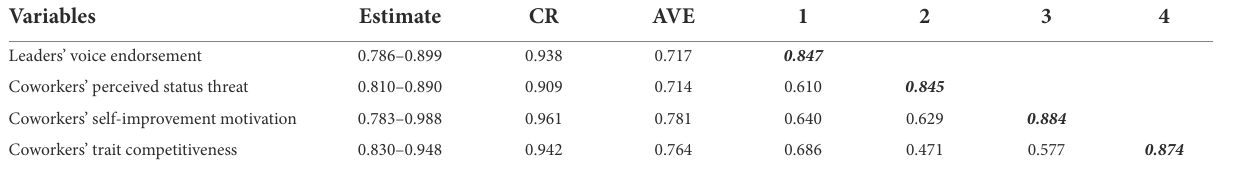
TABLE 1 Results of confirmatory factor analysis of each